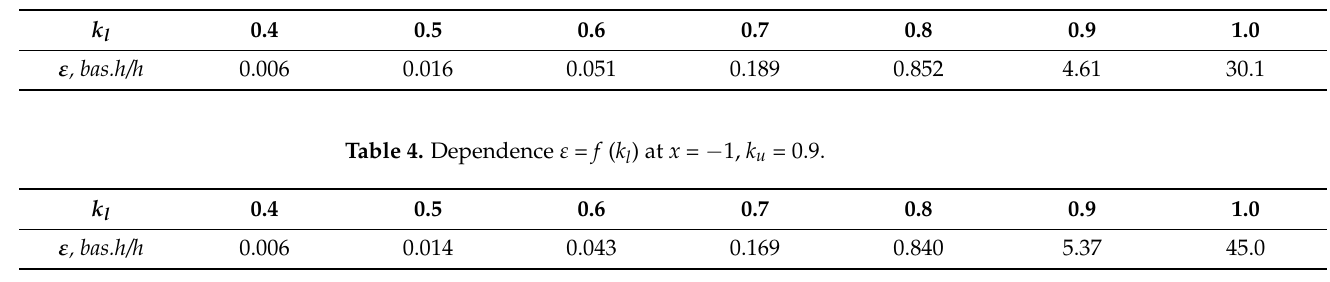
Table 3. Dependence ε = f ( k l ) at x = 2, k u = 0.9.